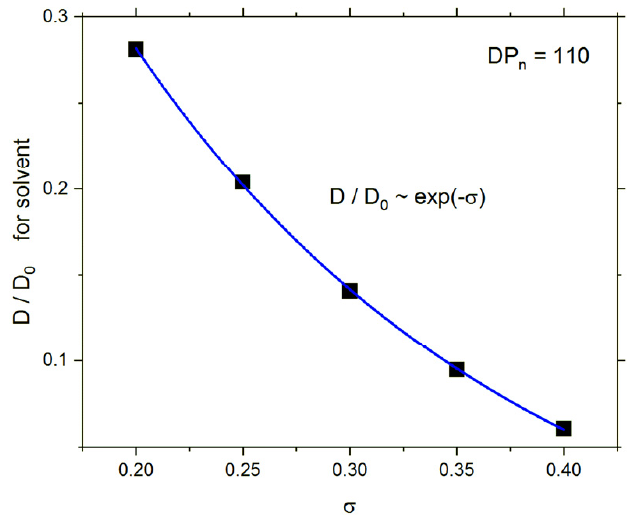
Figure 9. Solvent reduced self-diffusion coefficient D / D 0 as a function of grafting density σ . The dynamics of macromolecules in opposing polymer brush systems is also inter- esting as the motion of solvent molecules occurs in cooperation with polymer beads. The motion of the entire macromolecules is restricted due to their grafting, and therefore, the motion of chain ends, which are the most mobile, was studied. It should be noted that higher mobility of chain ends (when compared to inner polymer beads) was also found for free macromolecules in bulk [78,79]. It is shown that the upper part of the grafted chain relaxes an order of magnitude faster than the part close to the grafting point [42,43]. Figure 10 presents the mean squared displacement of chain ends as a function of time in a double logarithmic plot. Three different regimes can be distinguished for each degree of polymerization. In each regime, all chains exhibit the same scaling behavior regardless the degree of polymerization: the short time regime (below 10 2 ), where ∆ r 2 ~ t 0.91 ;